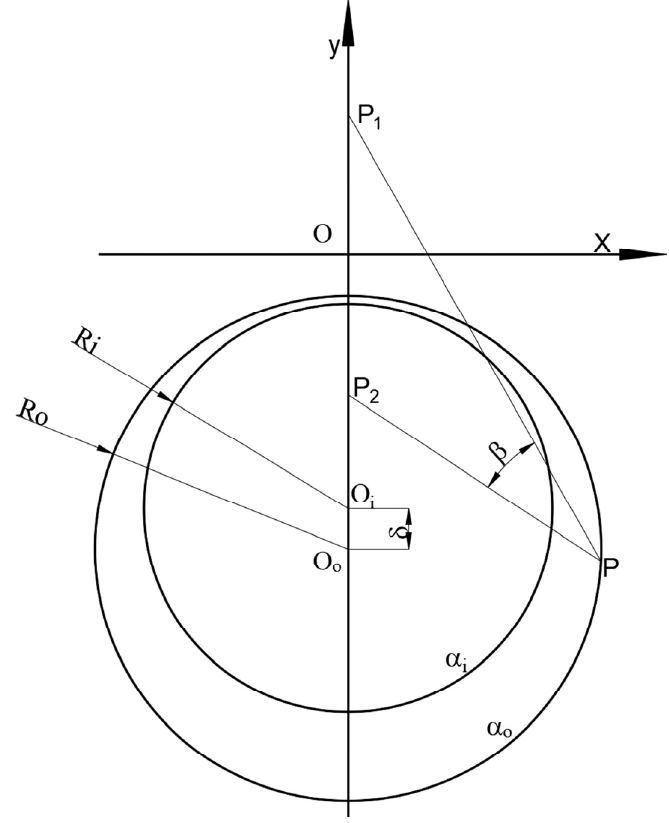
Figure 3. Illustration of the bipolar coordinate system